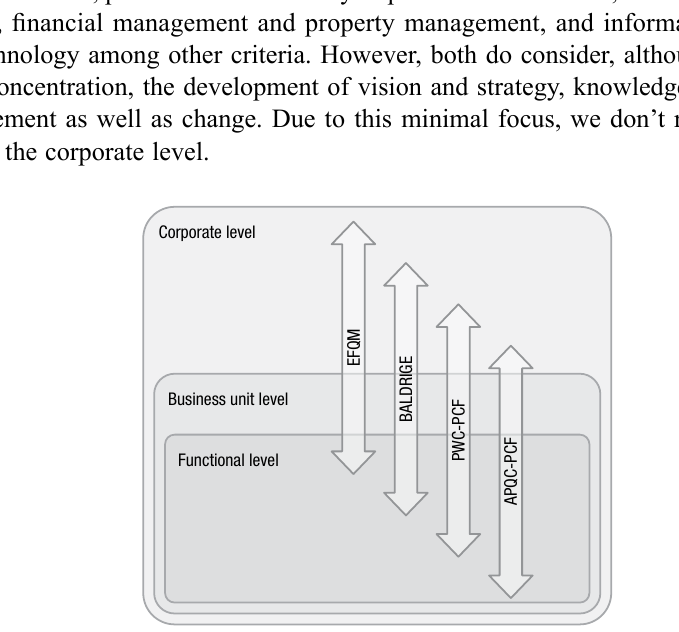
Fig. 4. Concentration of elements in each framework at different levels of an organization Source: created by